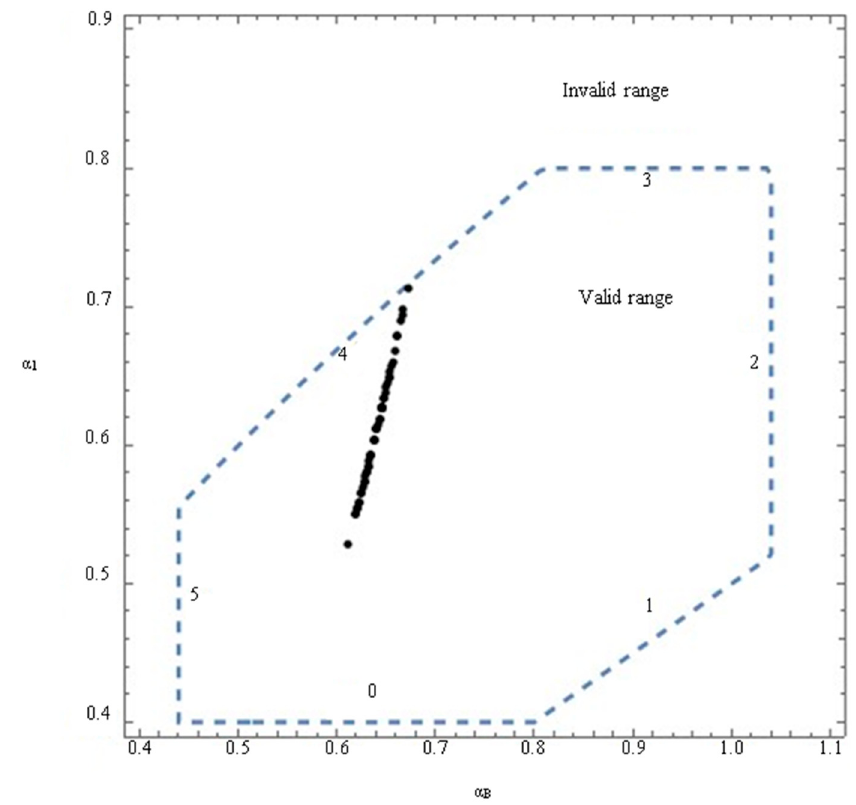
Figure 4. Position of the samples in the valid geometrical range.